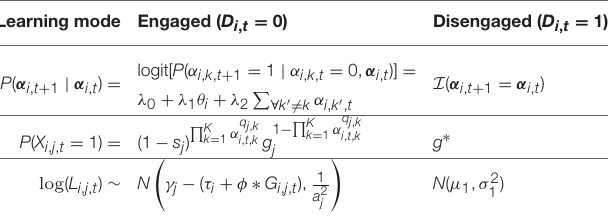
TABLE 1 | Components of the mixture learning model under different engagement modes. Learning mode Engaged ( D i , t = 0) Disengaged ( D i , t =